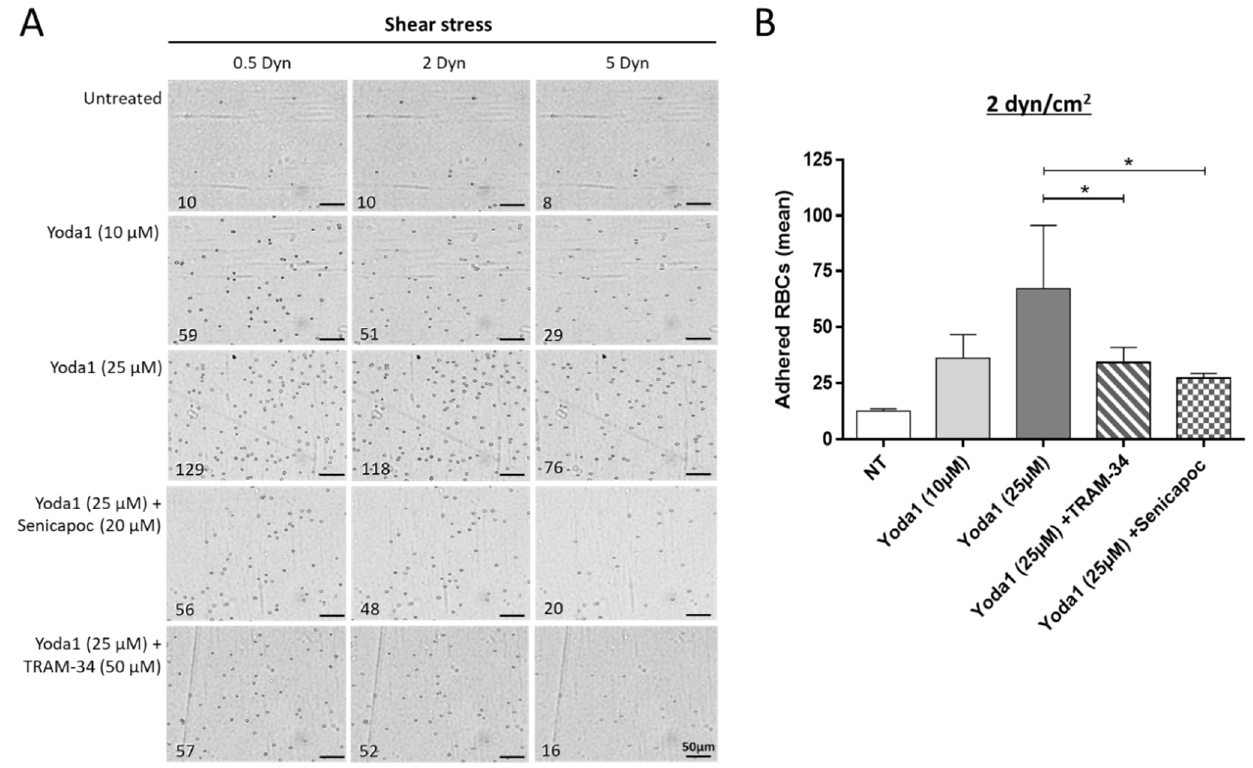
Figure 5. Adhesion of senescent AA RBCs to thrombospondin in vitro mimicked by chemical modulators of Piezo1 and inhibitors of the Gardos channels. Adhesion results for native AA RBCs from blood units and tested under physiological in-flow conditions using the Vena8 microslides coated with thrombospondin (TSP). Treatments were made with Yoda1 (10 and 25 μM) alone or in combination with the inhibitors of the Gardos channel, TRAM-34 (50 μM) or Senicapoc (20 μM) before perfusion. Adherent RBCs were counted in five representative areas at the three consecutive increasing shear stresses (first 0.5, then 2 and finally 5 Dyn/cm 2 ). (A) A representative photograph of RBCs adhered is shown for each condition, with the mean numbers of RBCs adhered indicated for each shear stress applied. The scale corresponds to 50 μm. (B) Results represented on the histograms show the adhesion mean results corresponding to a shear stress applied of 2 Dyn/cm 2 . The means of RBC adhesion results were: 12.6 ± 1.1 for non-treated RBCs (white bar); 36.2 ± 10.5 (light gray bar) and 66.9 ± 28.3 (dark gray bar) for the conditions treated with Yoda1 (10 and 25 μM, respectively); and 34.2 ± 6.7 (hatched bar) and 27.2 ± 2.1 (dotted bar) for the conditions treated with Yoda1 with the inhibitors TRAM-34 and Senicapoc, respectively. Data represent the mean of three independent experiments with * p < 0.05 (ratio-paired t test).